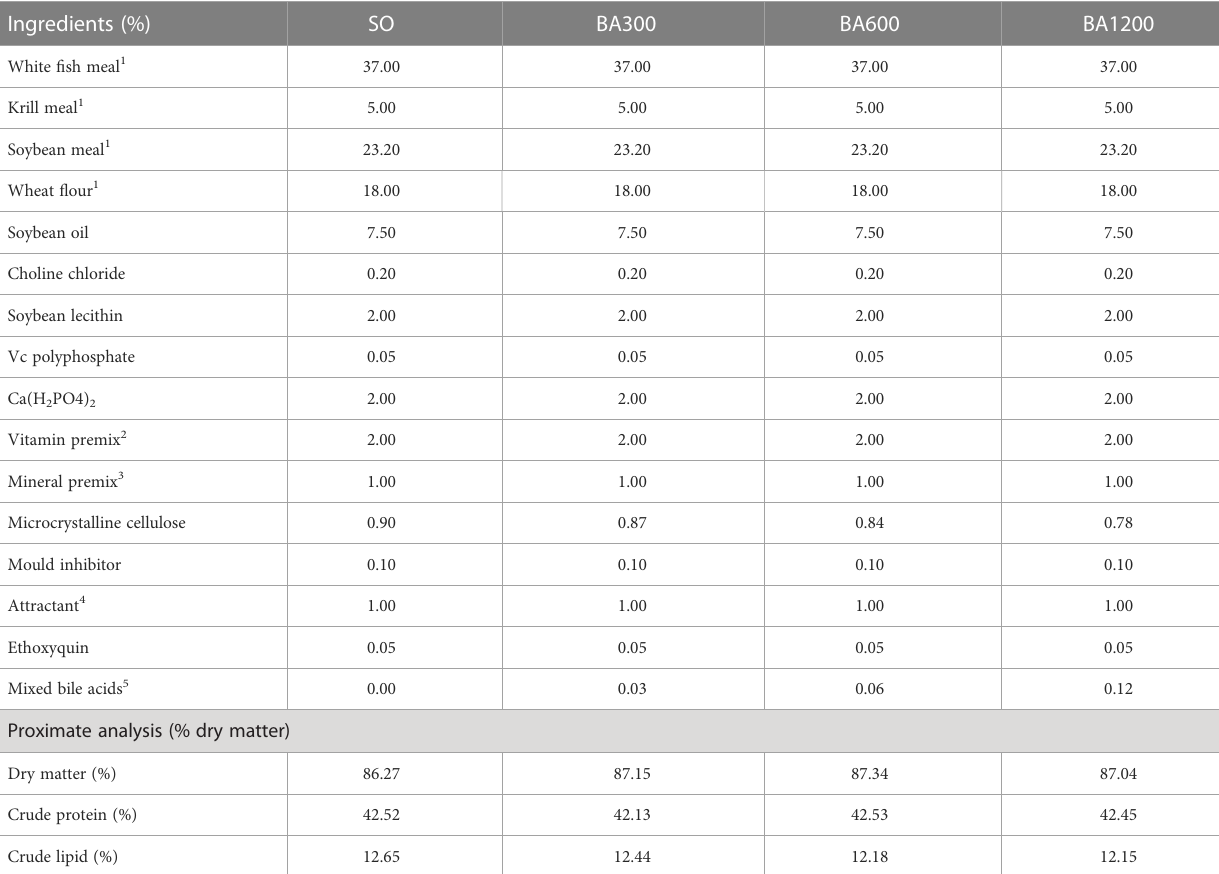
TABLE 1 Formulation and proximate composition of the experimental